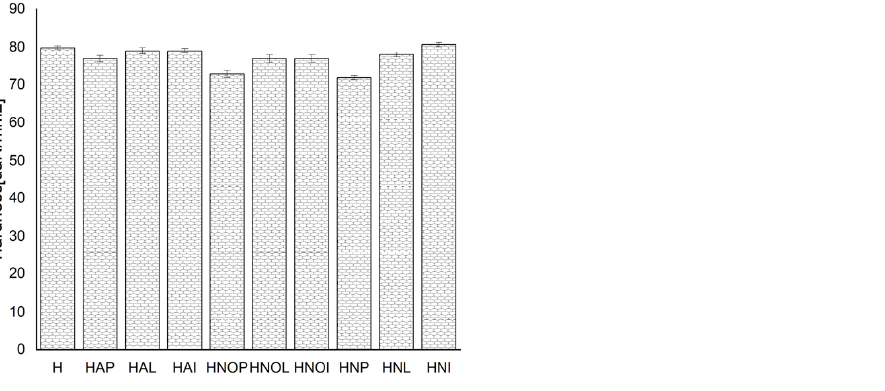
Figure 4. Evolution of hardness values of the experimental 5083 alloy samples, in different structural states .